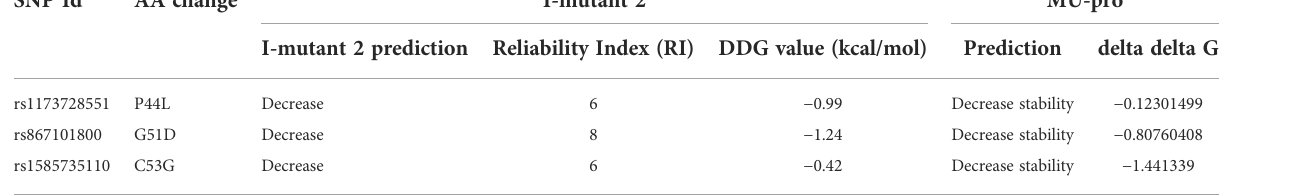
TABLE 2 Effects on h BD-2 stability with missense mutations.